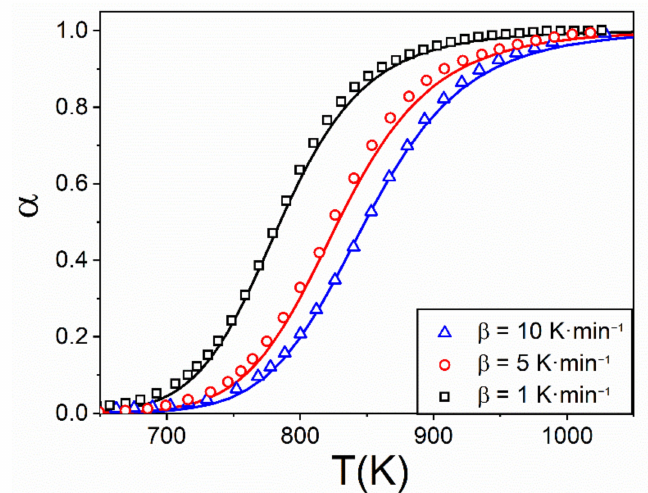
Figure 9. Reacted fraction as a function of temperature in the experiments conducted under linear heating conditions: 1, 5, and 10 K · min − 1 . Experimental data are depicted as open symbols. Solid lines represent the curves reconstructed using the modified Sestak–Berggren equation (Equation (13)), where n = 2.425 and m = −